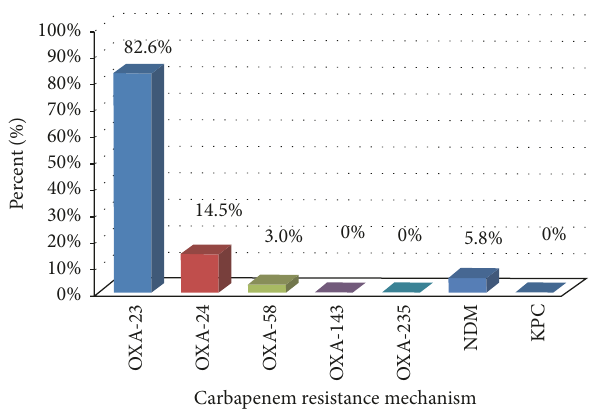
Figure 2: Histogram showing the distribution of carbapenemases in the Acinetobacter isolates tested.